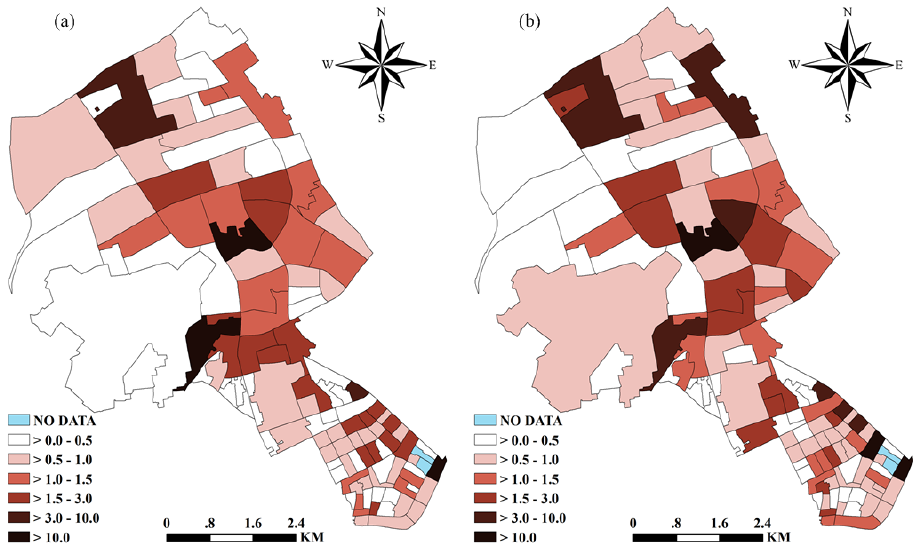
Figure 1. The posterior mean risks of ( a ) burglary and ( b ) non-motor vehicle theft estimated by the multivariate model.